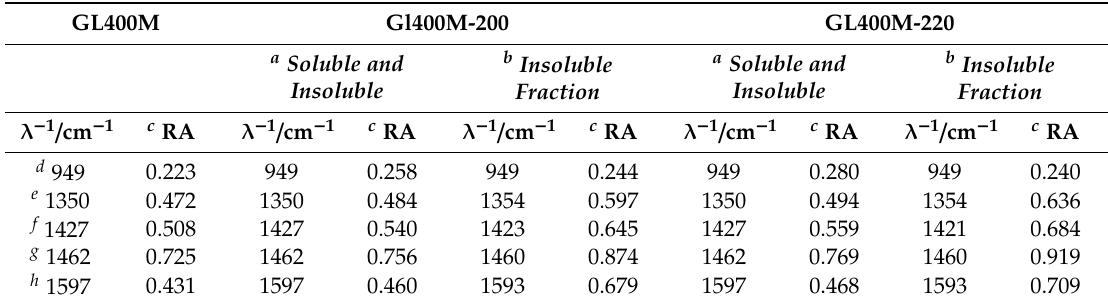
Table 3. ATR-FTIR spectral data for GL400M, heat-treated GL400M-200 and GL400M-220.